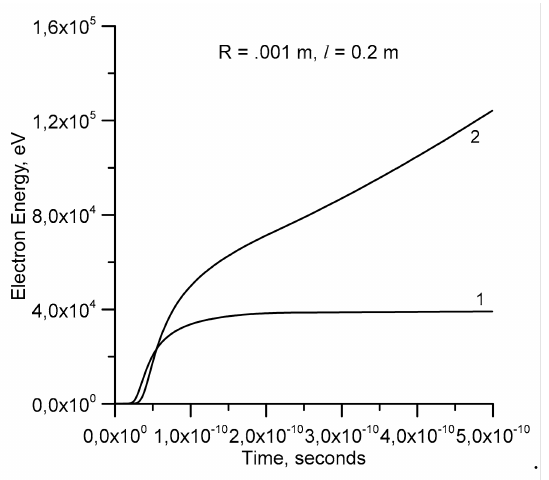
Figure 6. Effect of background electric field on the energy gained by the accelerating